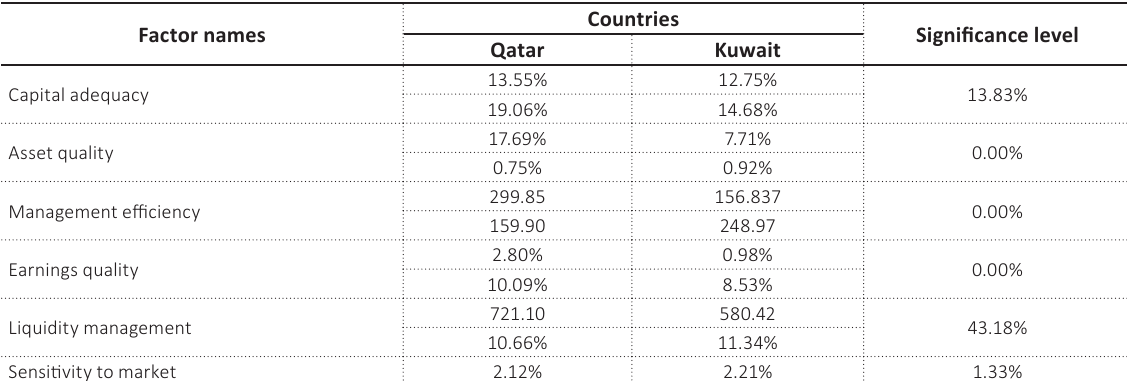
Table 10. The result of multivariate analysis of variance comparing the banks’ attributes in two